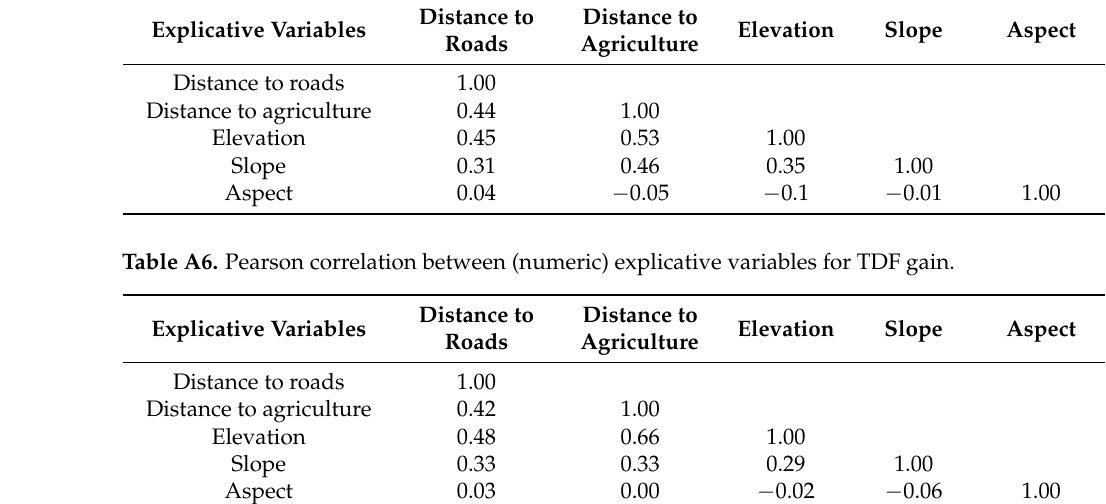
Table A5. Pearson correlation between (numeric) explicative variables for TDF loss.